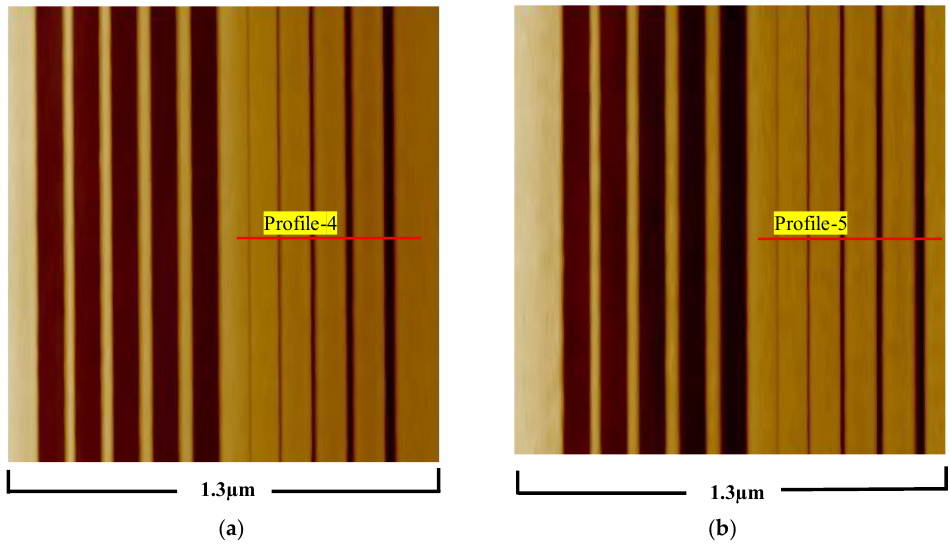
Figure 10. Scanning AFM image of tip characterizer along ( a ) X direction and ( b ) Y direction.